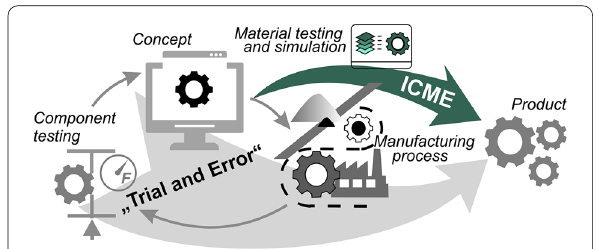
Figure 16 Schematic representation of the development cycle including the ICME approach as a digital design